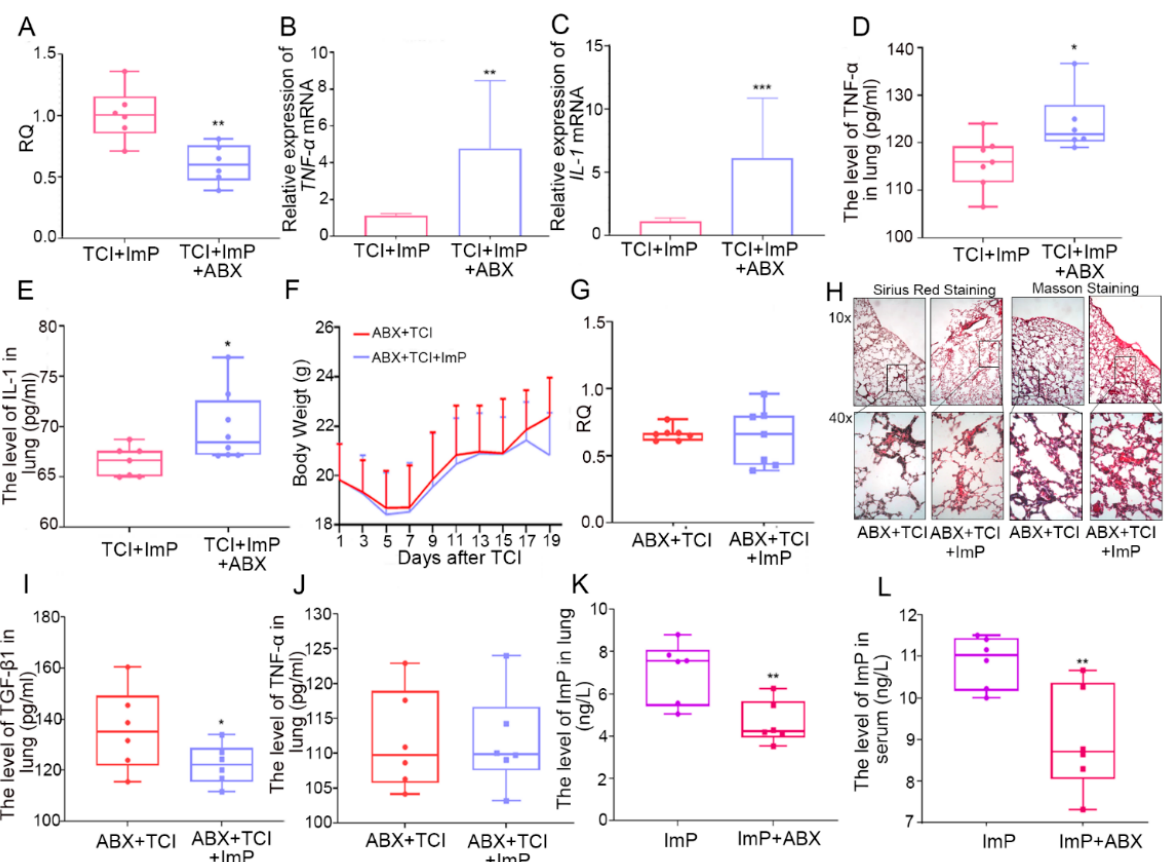
Figure 6. Gut microbiota impacts the assimilation of imidazole propionate. ( A ) The RQ in each group mice in 24 h ( n = 6). ( B , C ) The TNF- α and IL-1 levels in the lung tissues of each group mice were assessed by q-PCR. ( D , E ) The TNF- α and IL-1 levels in lung tissues of each group mice were assessed by ELISA ( n = 6). ( F ) The body weight of each group mice (not statistically significant). ( G ) The RQ in each group of mice after 24 h ( n = 7). ( H ) The lung tissues of each group mice were stained with Sirius Red and Masson in the ABX-treated group after TCI. ( I , J ) The TGF- β 1 and TNF- α levels in lung tissues of each group of mice were assessed by ELISA ( n = 6). ( K ) The level of ImP in lung were assessed by ELISA ( n = 6). ( L ) The level of ImP in serum were assessed by ELISA ( n = 6). (The data are presented as mean ± SD, * p < 0.05, ** p < 0.01 and *** p < 0.001; Student’s t -test.).